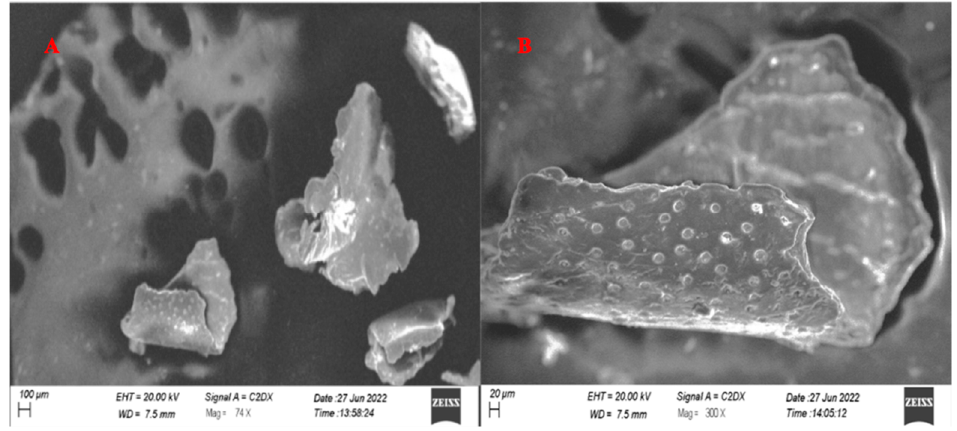
Figure 8. SEM image of synthesized PEGylated chitosan at ( A ) 74× and ( B ) 300×.